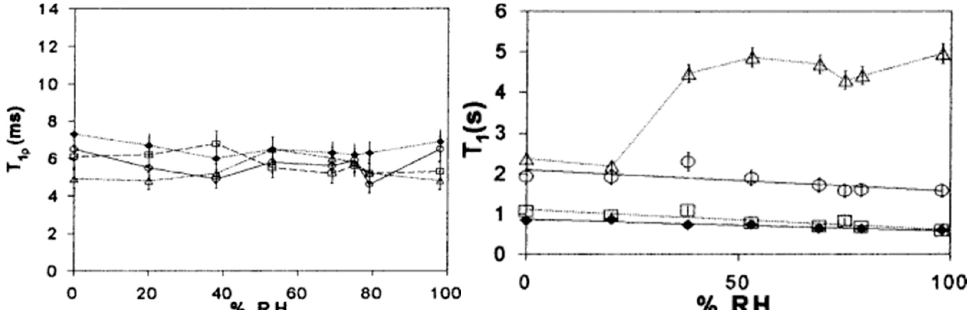
Figure 11. ssNMR study of several lyophilized protein formulations containing different amounts of lysozyme and trehalose. On the left average T 1 ρ is plotted against relative humidity (% RH), whereas on the right average T 1 is plotted against % RH. —trehalose; —80% trehalose, 20% lysozyme; □ —20% trehalose, 80% lysozyme; —lysozyme. Reproduced with permission from [116], Elsevier, 2002.